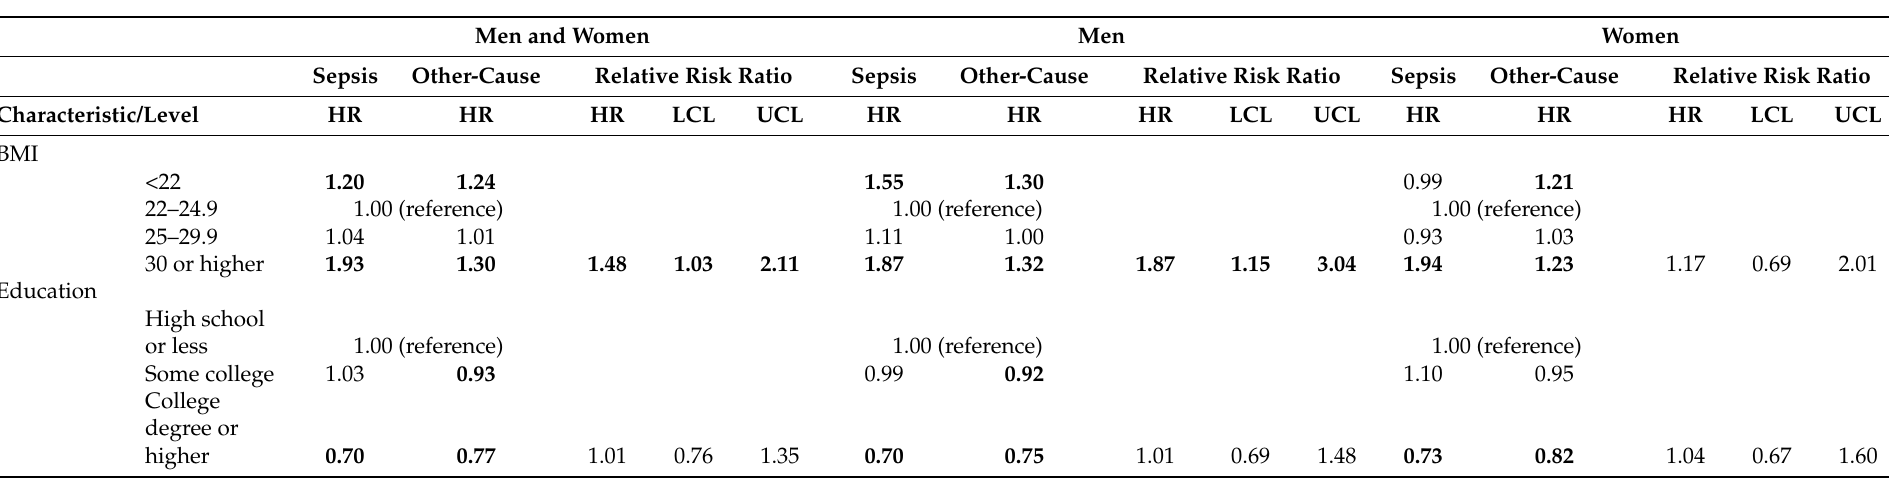
Table 3. Associations of participants’ characteristics with sepsis and other-cause mortality among all participants in the Multiethnic Cohort. Men and Women Men